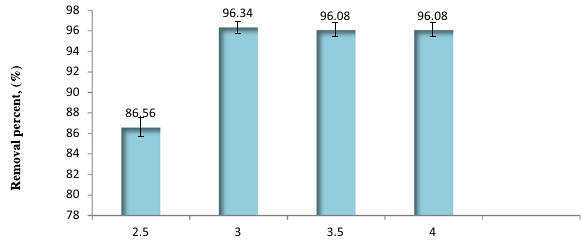
Fig. 4 Effect of pH on the removal percent of iron III by using A. Niger as bioadsorbent when the initial concentration was (10 − 2 M) using 4 g/100 ml of the biomass at room temperature and for 60 min time contact. n = 3 determinations.